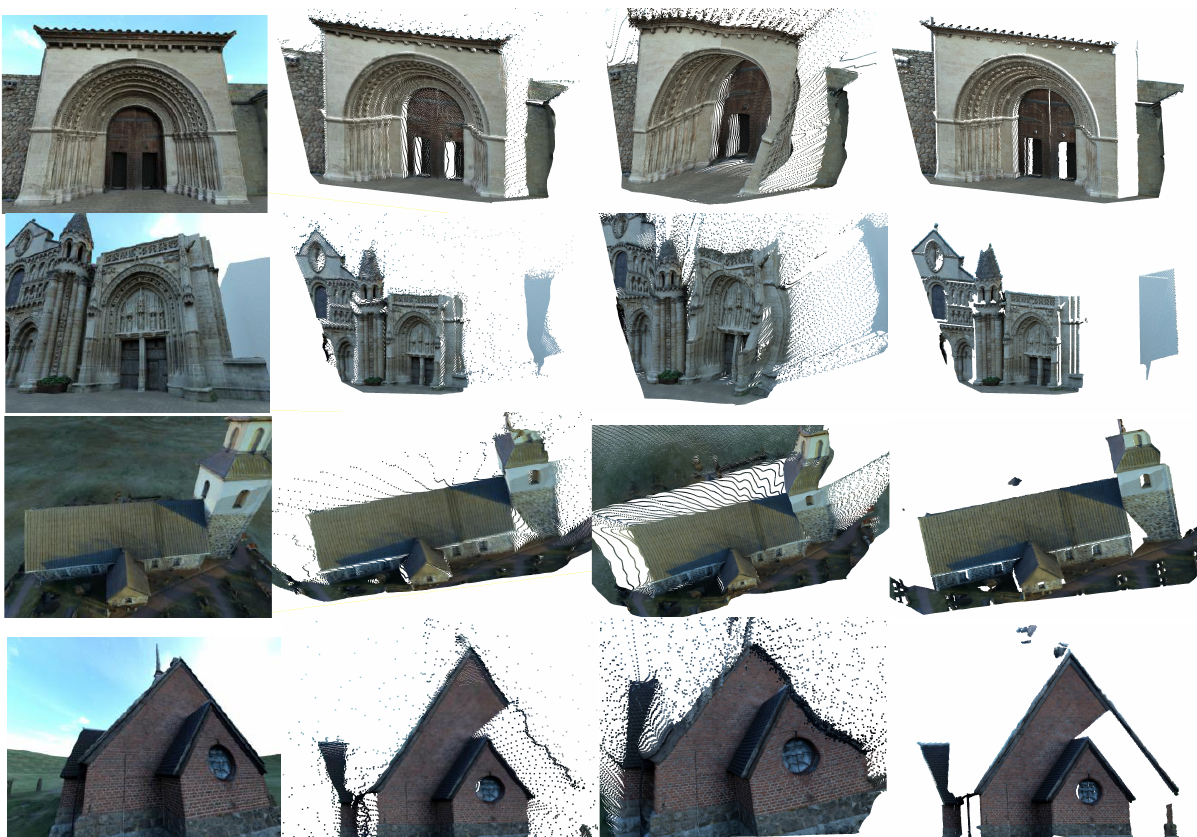
Figure 5. Experiment 1. (a) RGB input image (b) reconstructed point cloud (c) LeRes point cloud (d) GT point